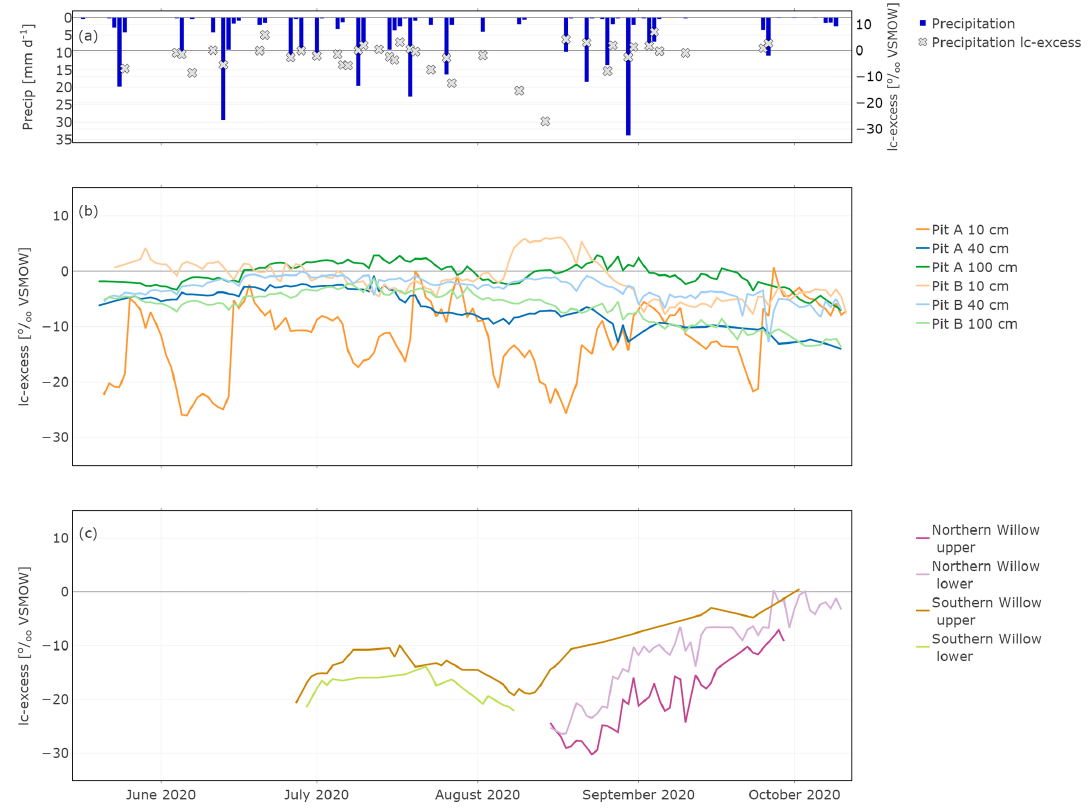
Figure 6. In situ time series of daily lc-excess in precipitation (a) , Pit A and Pit B (b) , and Northern Willow and Southern Willow (c) .